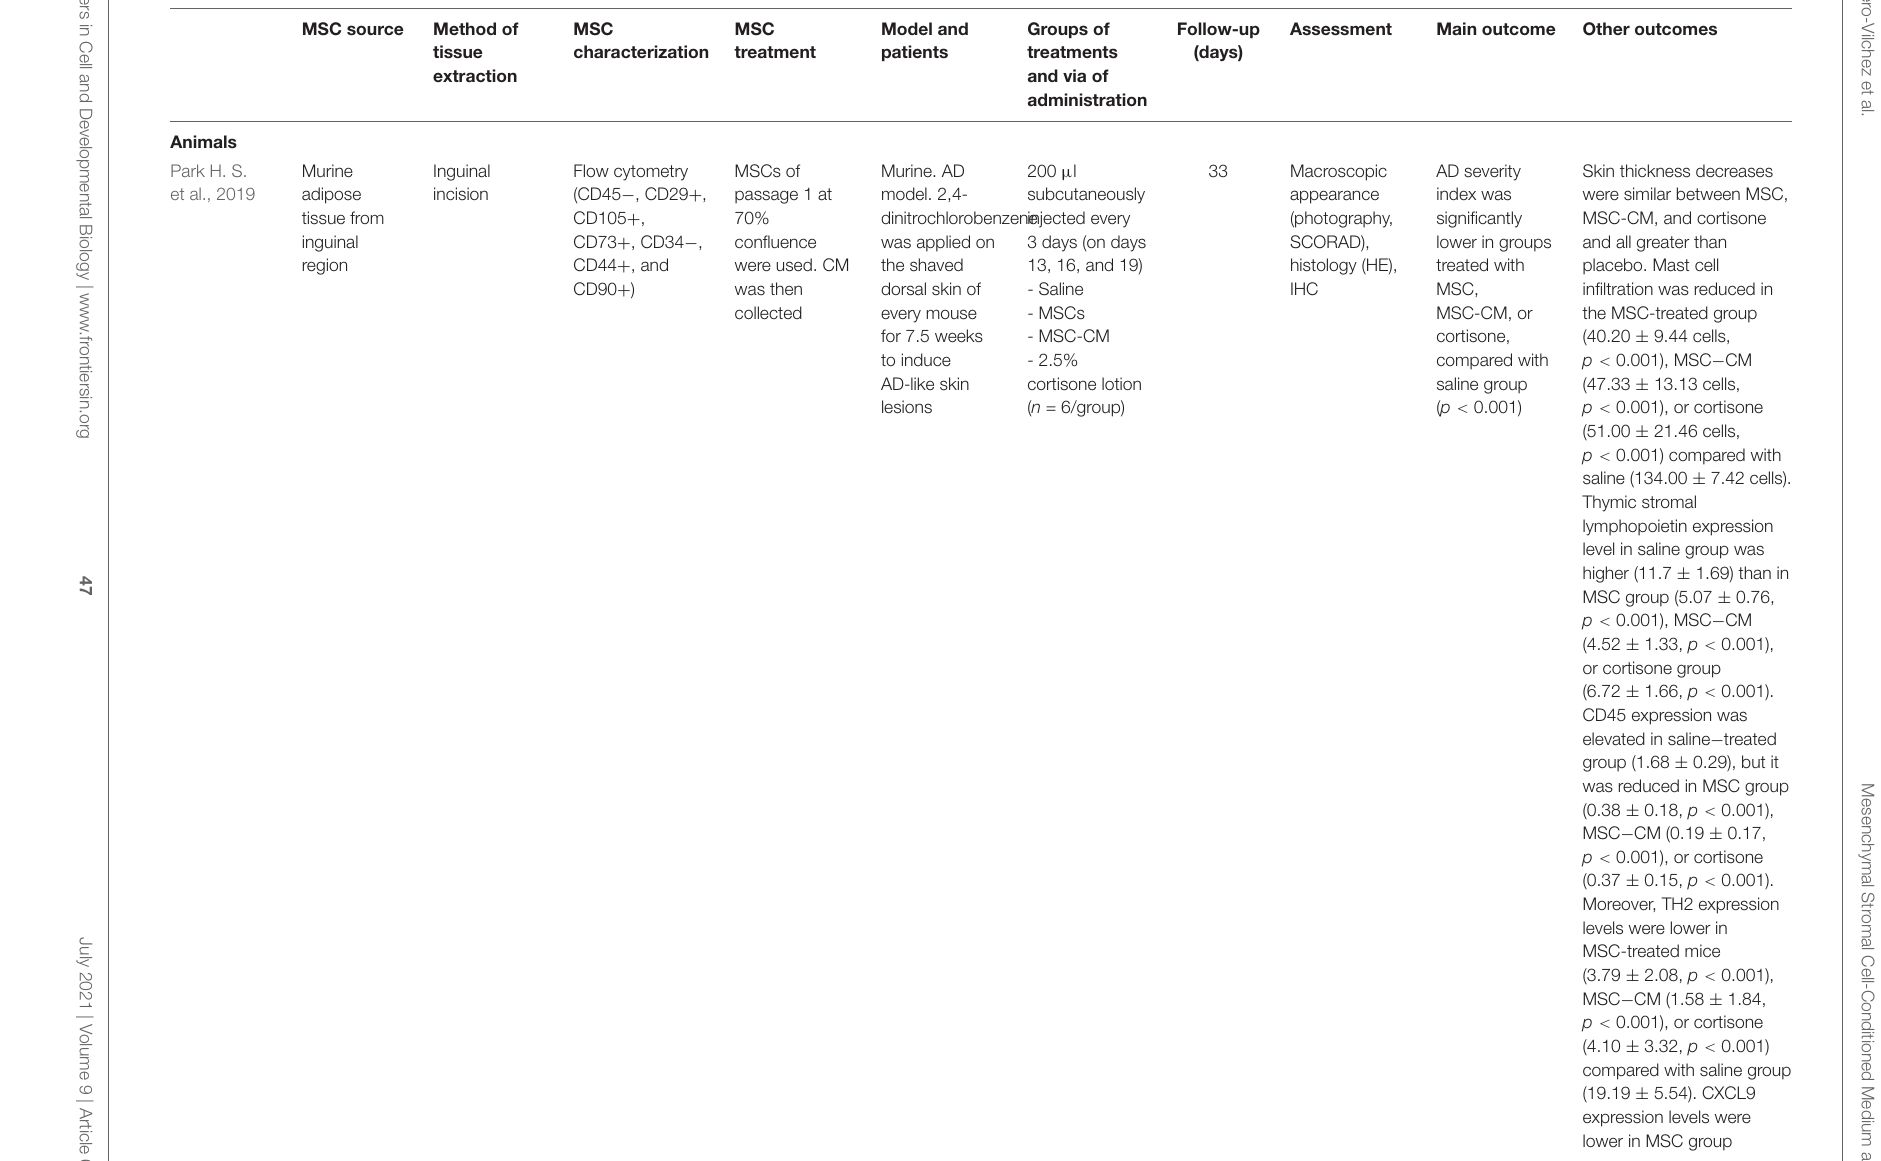
TABLE 11 | Studies regarding mesenchymal stromal cell- conditioned medium for treating inflammatory skin